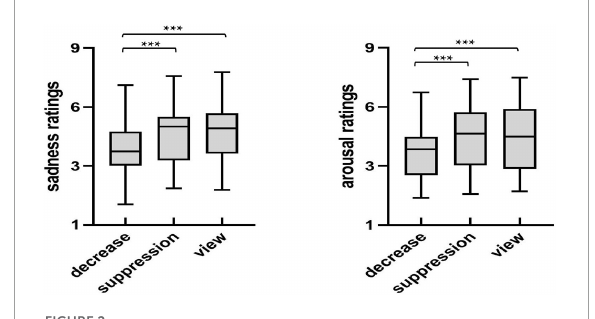
FIGURE2 The sadness and arousal ratings of sad images after regulation. * p < 0.05, ** p < 0.01, *** p <